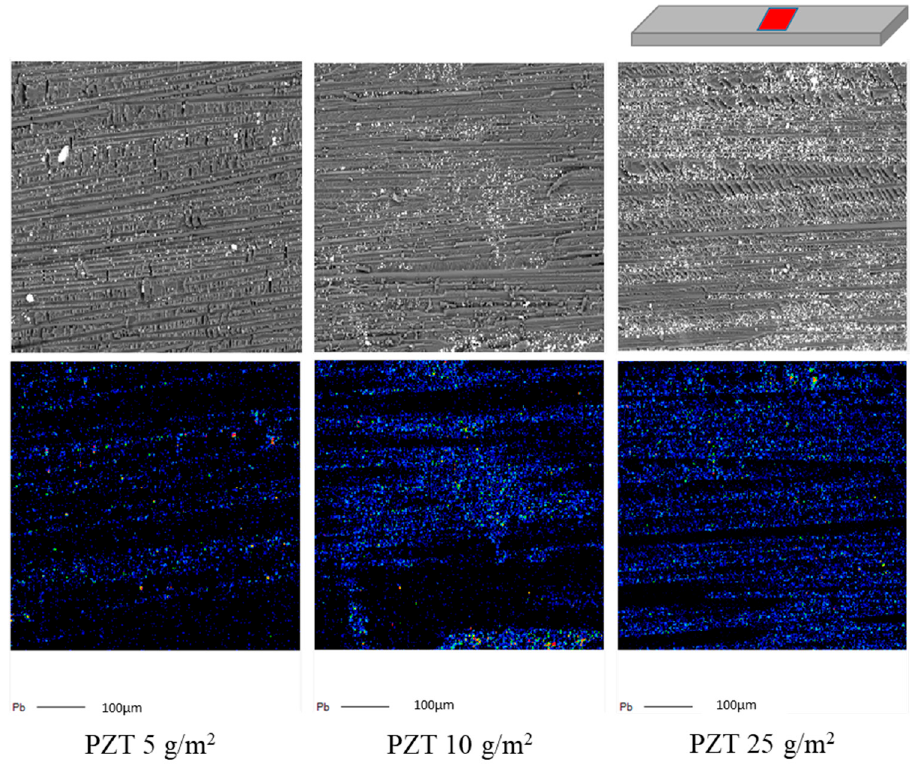
Figure 6. EPMA mapping images of lead (Pb) for evaluation of the dispersion of PZT in CFRP specimens. The blue dots show the degree of dispersion of the layer. The brighter the color, the stronger the signal from lead, which can be seen as large or clumped particles.